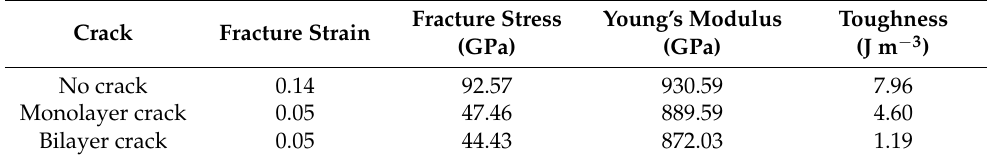
Figure 11. Comparison of stress–strain curves of the bilayer graphene with (black) no crack, (red) the crack on a single layer, and (blue) the cracks on both layers for ( a ) the rectangular crack along the y -axis, and ( b ) the circular crack. Table 4. Rectangular crack along the y -axis (l = 10 Å).